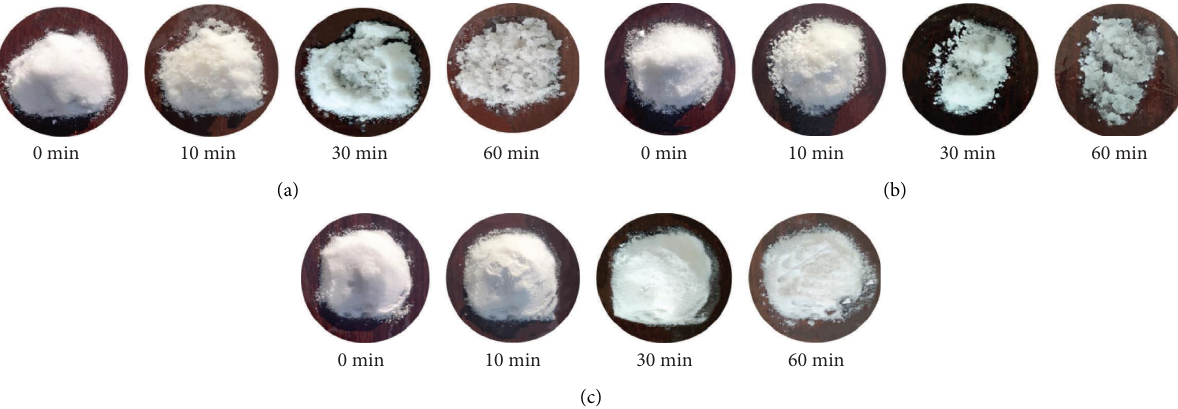
Figure 6: Snow-melt efect diagram for (a) magnesium chloride (10 g); (b) potassium acetate (10g); (c) sodium sulfate (10g).